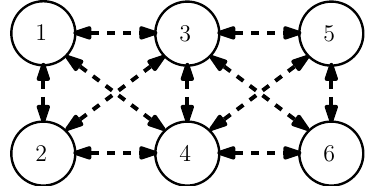
Figure 6. A new network constituted by 6